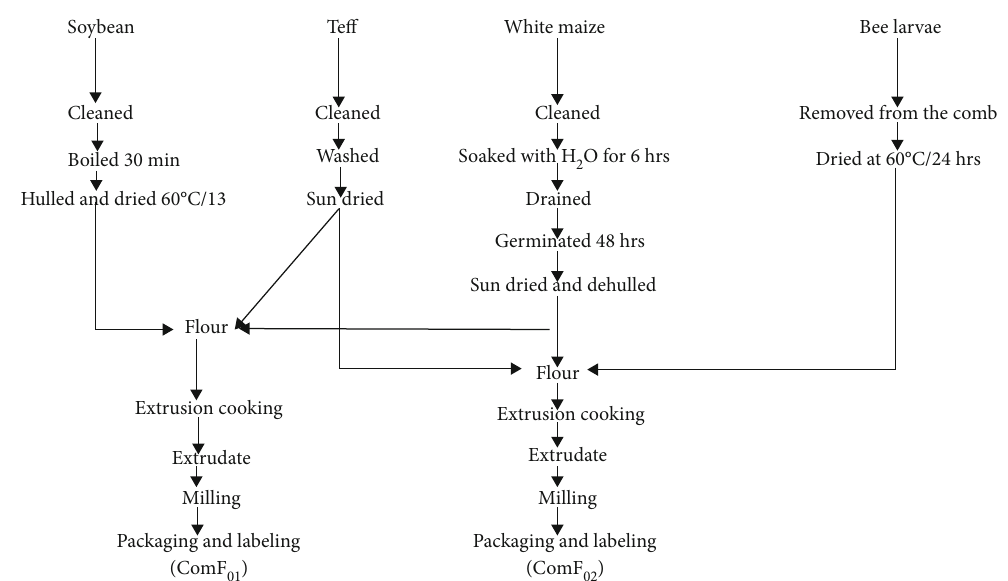
Figure 1: Flow chart of sample processing, formulation, and complementary food